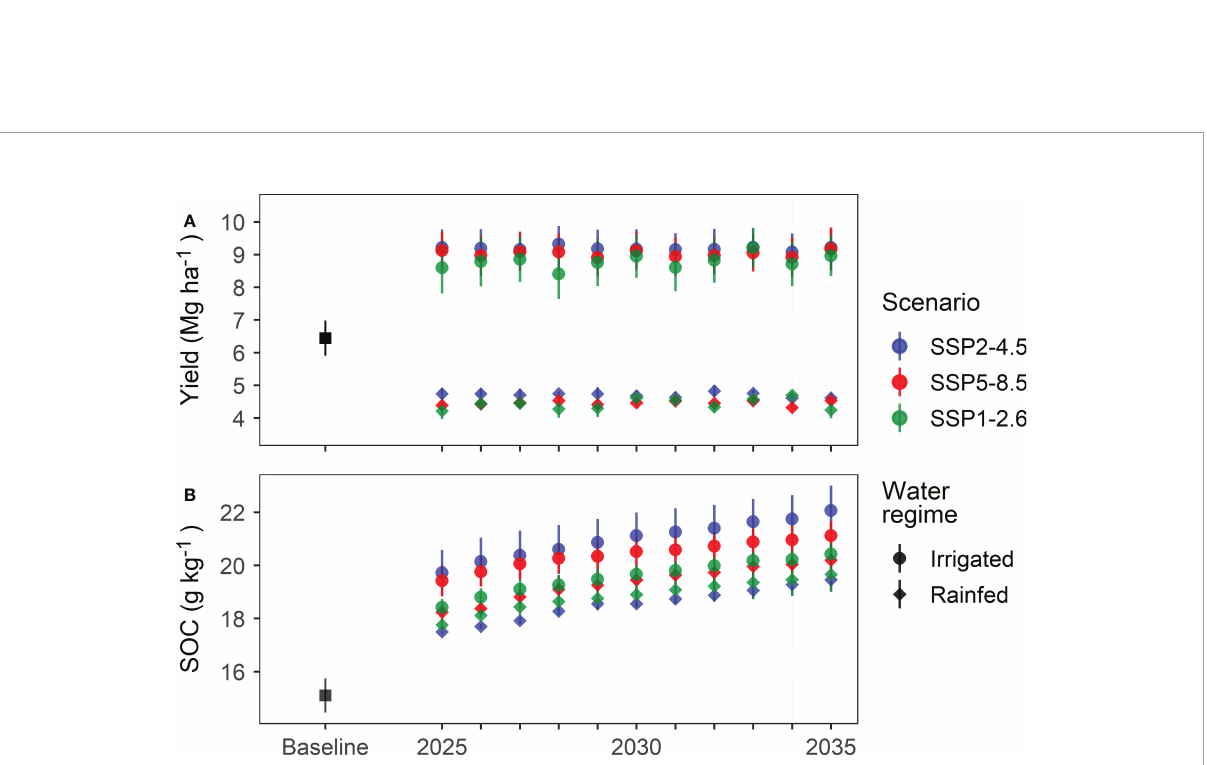
FIGURE 6 DNDC-simulated average yield (A) of and 0-30 cm soil organic carbon content (SOC, B ) under sown alfalfa pastures on marginal land in northern China under three IPCC SSP scenarios from 2025 to 2035. Experimental observations from 2012 to 2017 are included as the baseline for